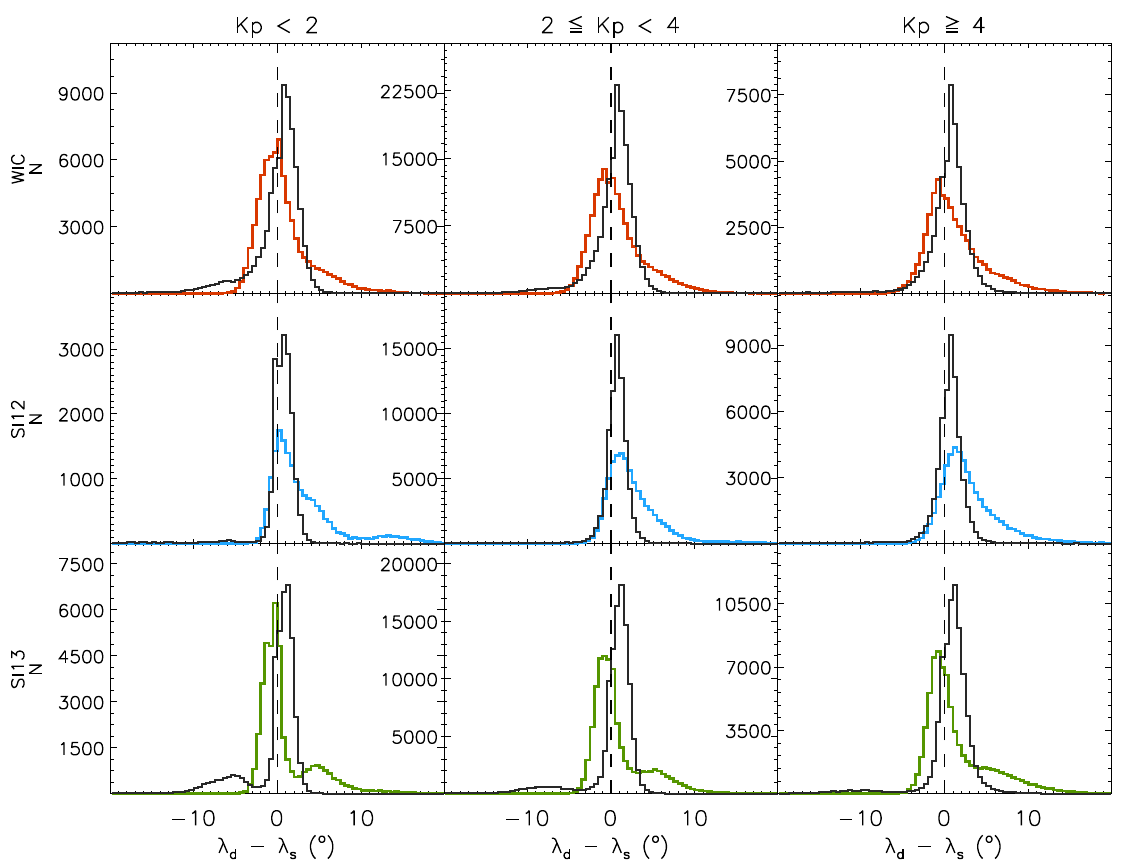
Fig. 5. Distribution of differences in auroral luminosity boundaries derived from single Gaussian ( F s (λ) ) and double Gaussian fits ( F d (λ) ) when both models successfully produce boundary locations under differing levels of geomagnetic activity, inferred from the Kp index. The coloured curves show the distribution of PALB differences for each of the three IMAGE FUV detectors during May 2000 to August 2002. The black curves in each panel show the distribution of EALB differences. Table 2. Sample size ( N ), mean ( µ ), standard deviation ( σ ), 25th percentile (25%), median (50%), and 75th percentile (75%) for the differences between DMSP PAPBs and IMAGE FUV PALBs, during 2000 and 2001. Differences have been included only when PALBs are successfully located from fits of both single and double Gaussian functions to an auroral intensity profile and the double Gaussian is the superior